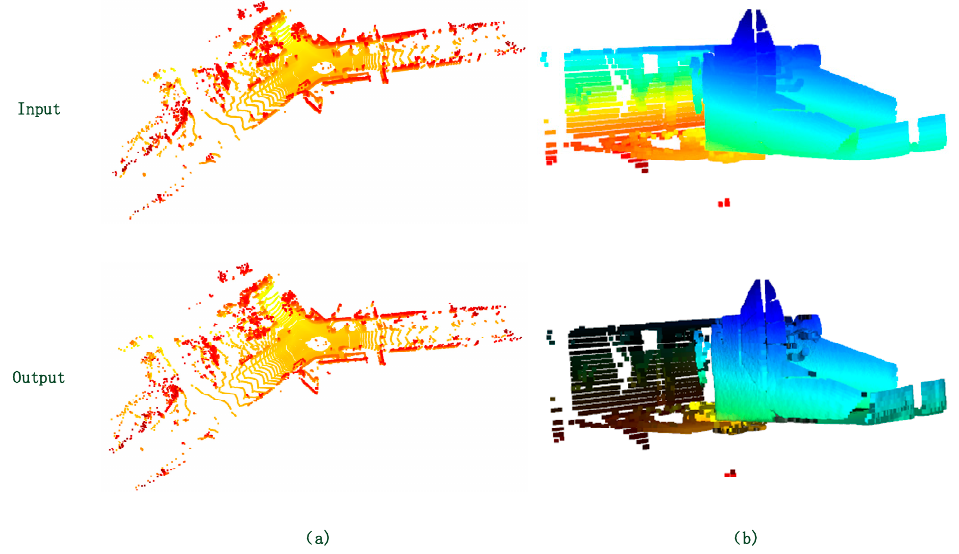
Figure 9. ( a ) The visualization of KITTI dataset. ( b ) The visualization of ETH dataset.